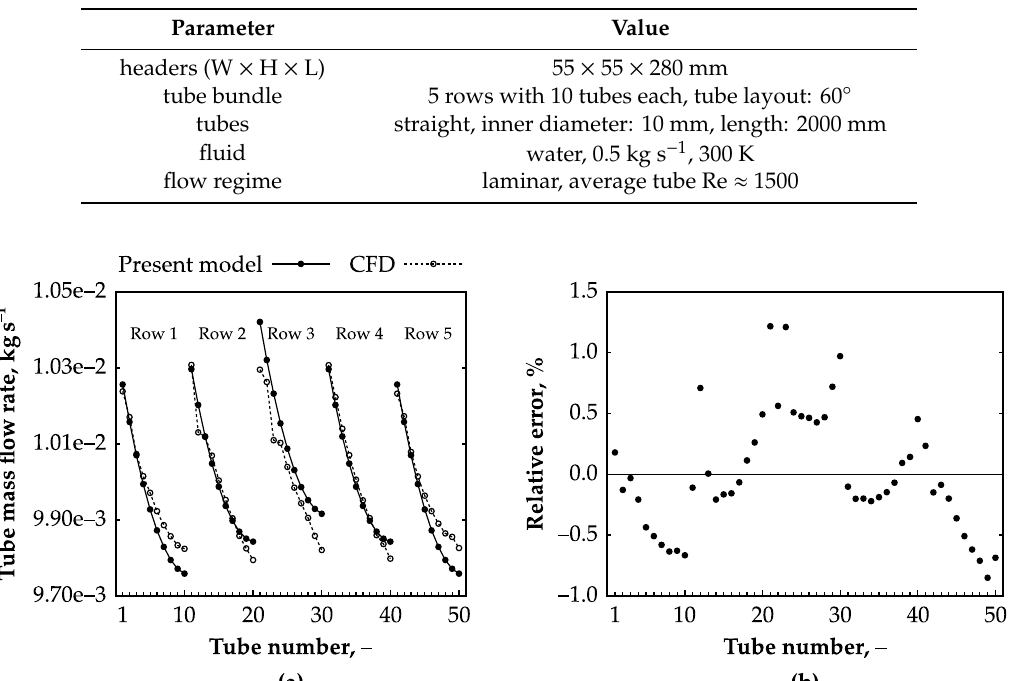
Table 1. Parameters of the flow distribution system used to obtain the laminar flow-related data shown in Figure 1.